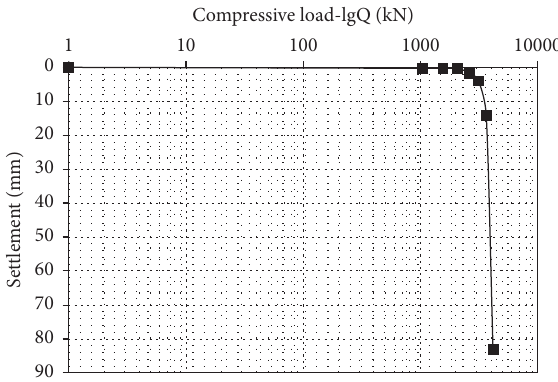
Figure 15: s-lgQ curve of